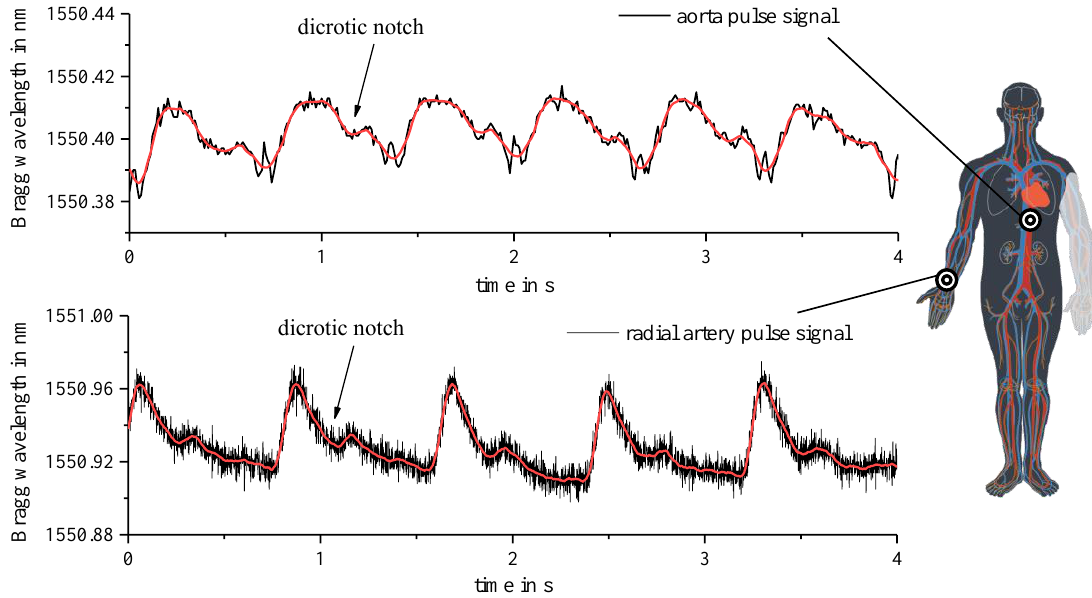
Figure 6. Epoxy-based sensor pad applied for monitoring aorta and radial artery pulse signs of a test person (draft of circulatory system based on [30]).